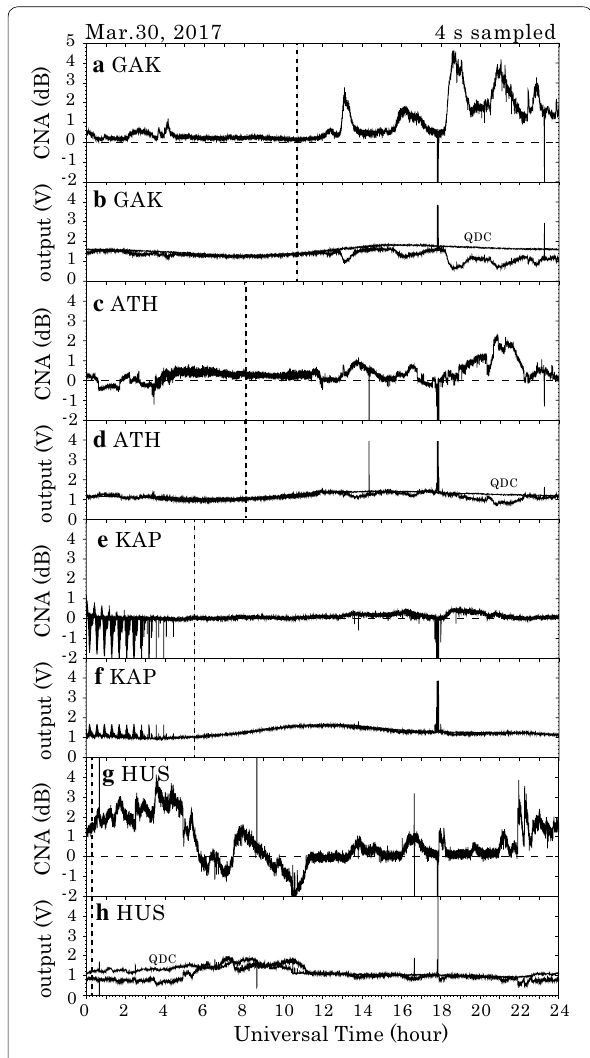
Fig. 10 Output voltages, quiet‑day curves (QDCs) and cosmic noise absorption (CNA) measured by the broad‑beam riometer at GAK, ATH, KAP, and HUS on March 30, 2017. Vertical dashed lines indicate the time of zero MLT (magnetic midnight) at each